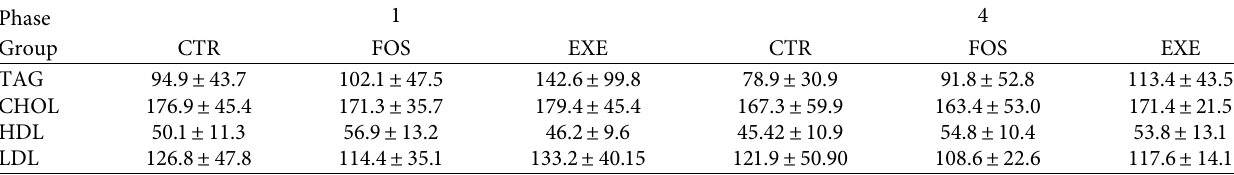
Table 2: Metabolic profile in celiac disease patients and healthy people—intergroup analysis. Phase